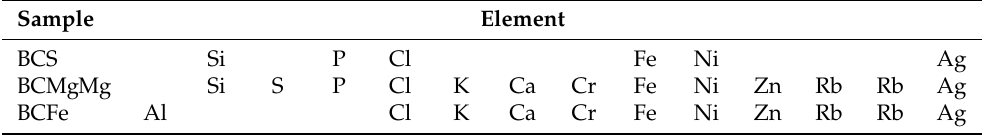
Table 2. Identified elements by X-ray fluorescence (XRF) (K α levels).